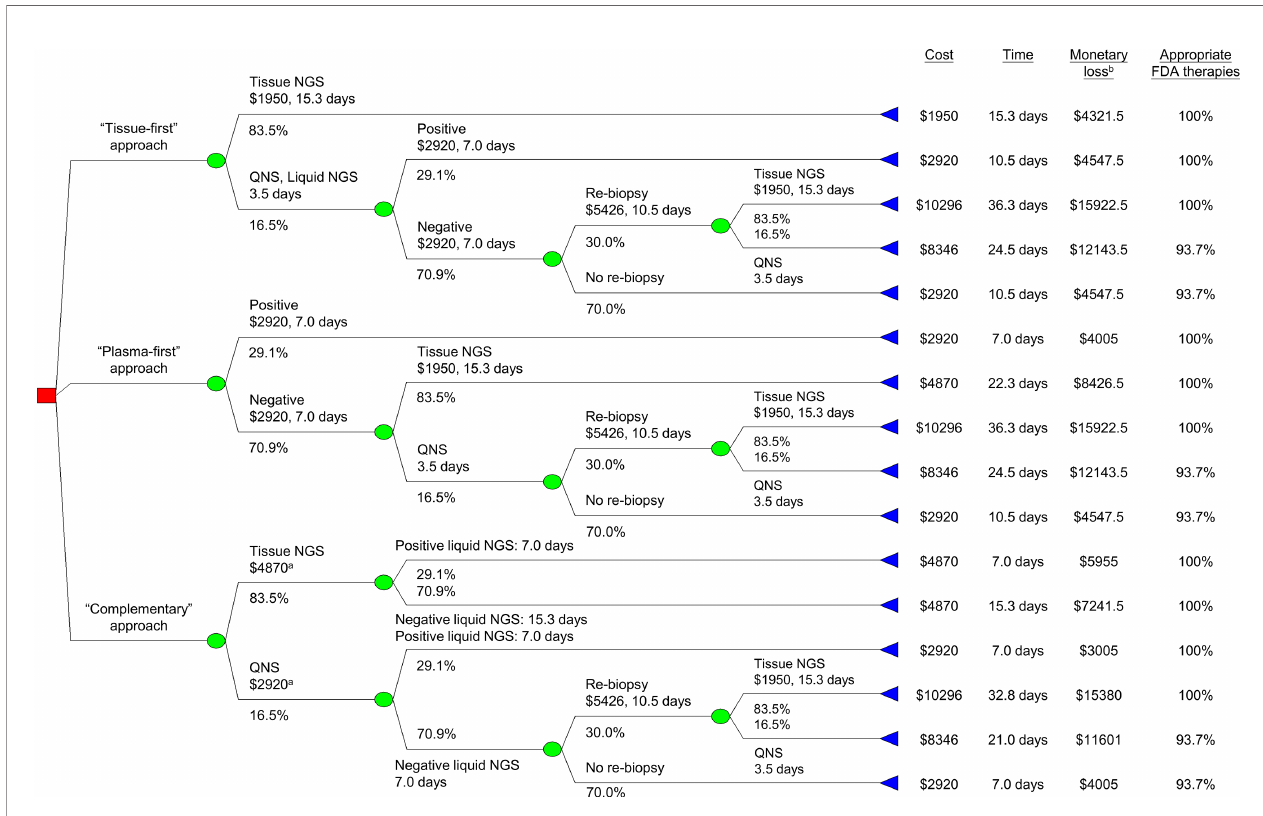
FIGURE 1 | Decision tree analysis for minimizing monetary loss. a Including cost for liquid-based NGS. b Monetary loss included both testing and productivity costs, latter was the product of turnaround time and average wage ( Table 1 ). FDA, U.S. Food and Drug Administration. NGS, next-generation sequencing; QNS, quantity not suf fi